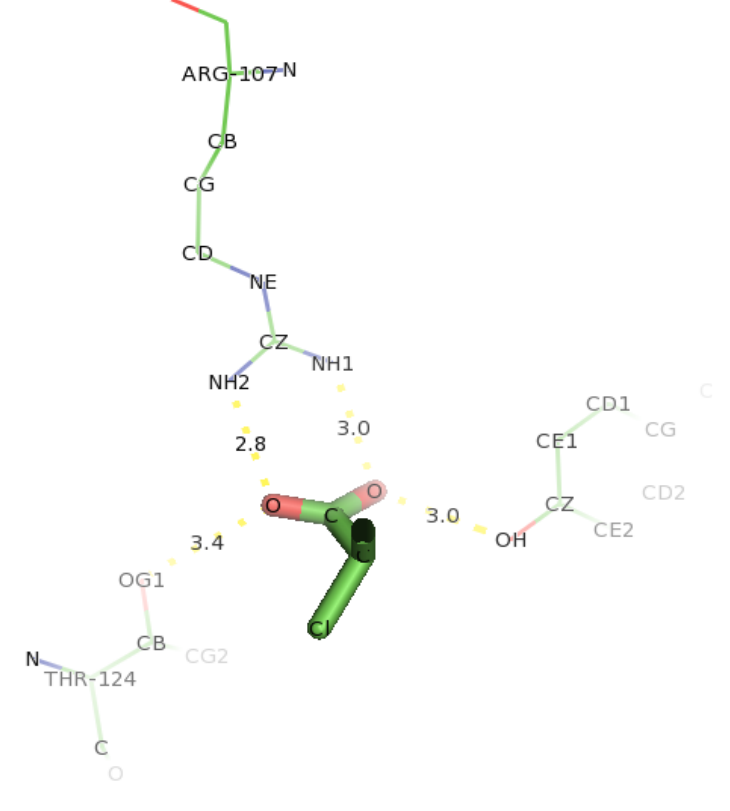
Figure 13. The interacting residues of DehD protein with D -2CP after 5000 ps MD simulation showing hydrogen bonding. Hydrogen bond distances are in